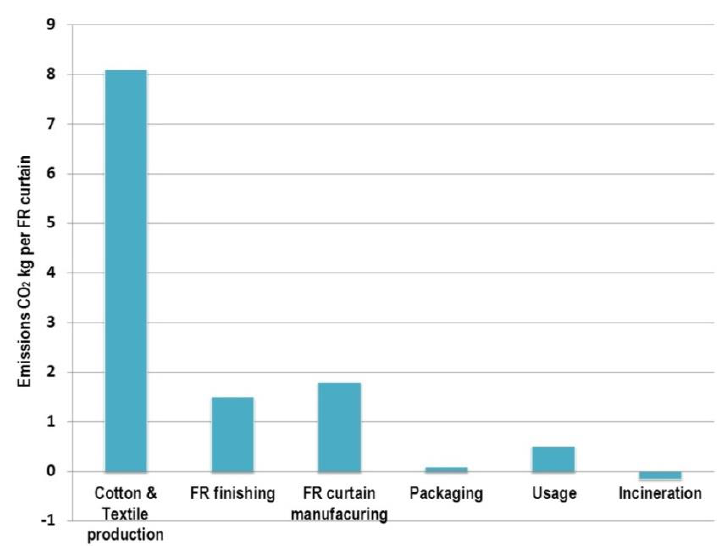
Figure 4. Carbon emissions by one kilogram of FR cotton curtains.